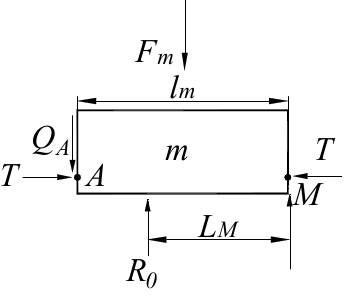
Figure 7. The mechanical model of rock block m.